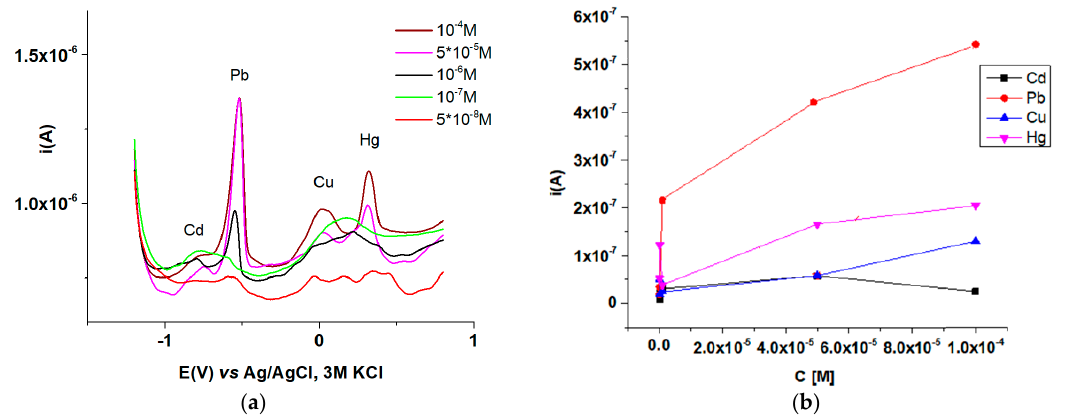
Figure 11. DPV stripping currents in acetate buffer at pH 5.5 for poly L ‐ modified electrodes obtained by CPE (+0.8 V,1 mC) in L solution (1 mM) in 0.1 M TBAP/CH 3 CN, after being immersed in water containing different concentrations of heavy metals ( a ) and the DPV stripping current’s dependence on heavy metal ion concentrations for Cd, Pb, Cu and Hg ( b ).